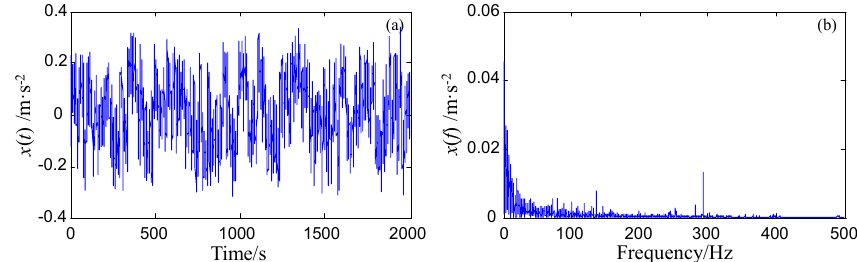
Figure 13. The detection results based on FRSR after frequency scale recovery.